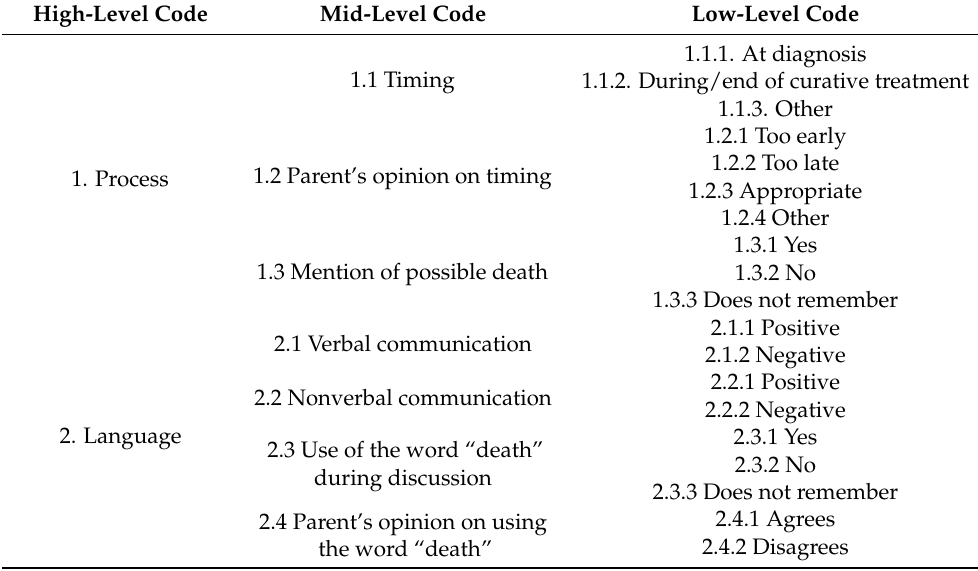
Table 2. Simplified code tree; coding was performed with low-level